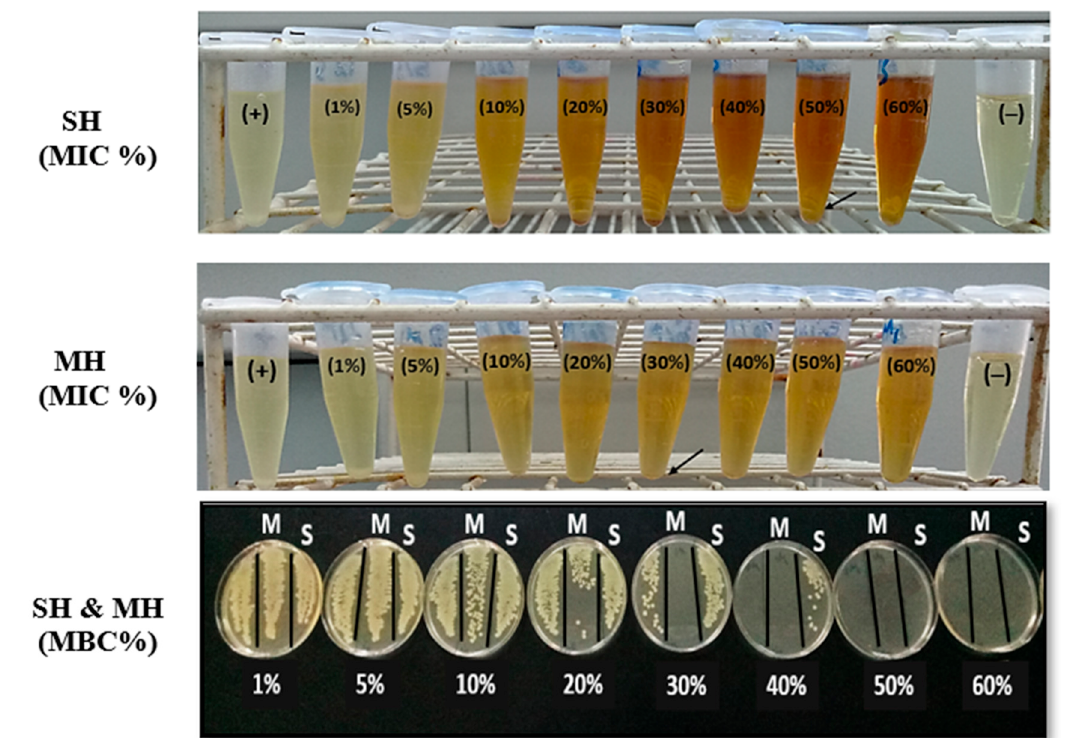
Figure 1. Photos show the minimum inhibitory concentration (MIC) and minimum bactericidal concentration (MBC) of Sidr honey (SH) and Manuka honey (MH); (+): positive control (bacteria with broth medium); (–): negative control (only broth medium).